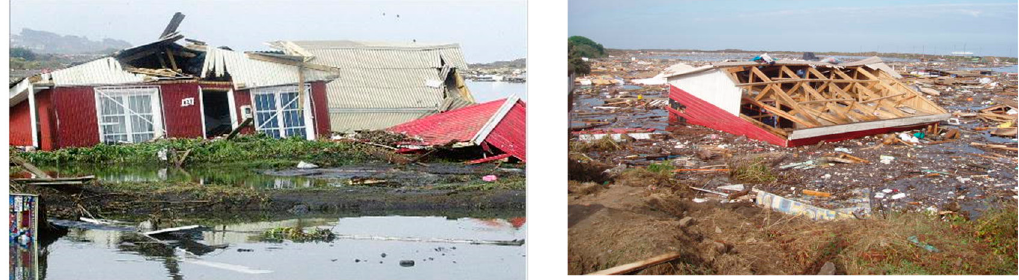
Figure 2. Damage in the San Antonio area caused by the 27 February 2010 tsunami [35].